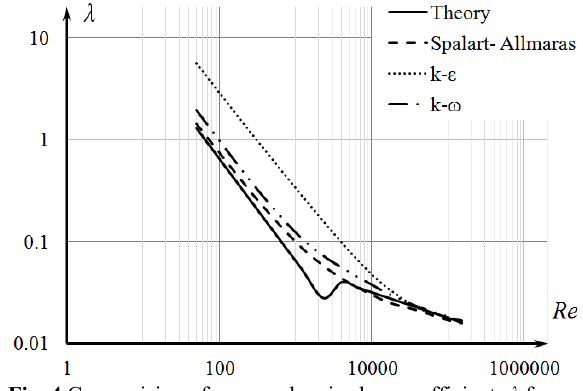
Fig. 4 Comparision of avereged major loss coefficients λ from simulation with theoretical [1, 7-9]